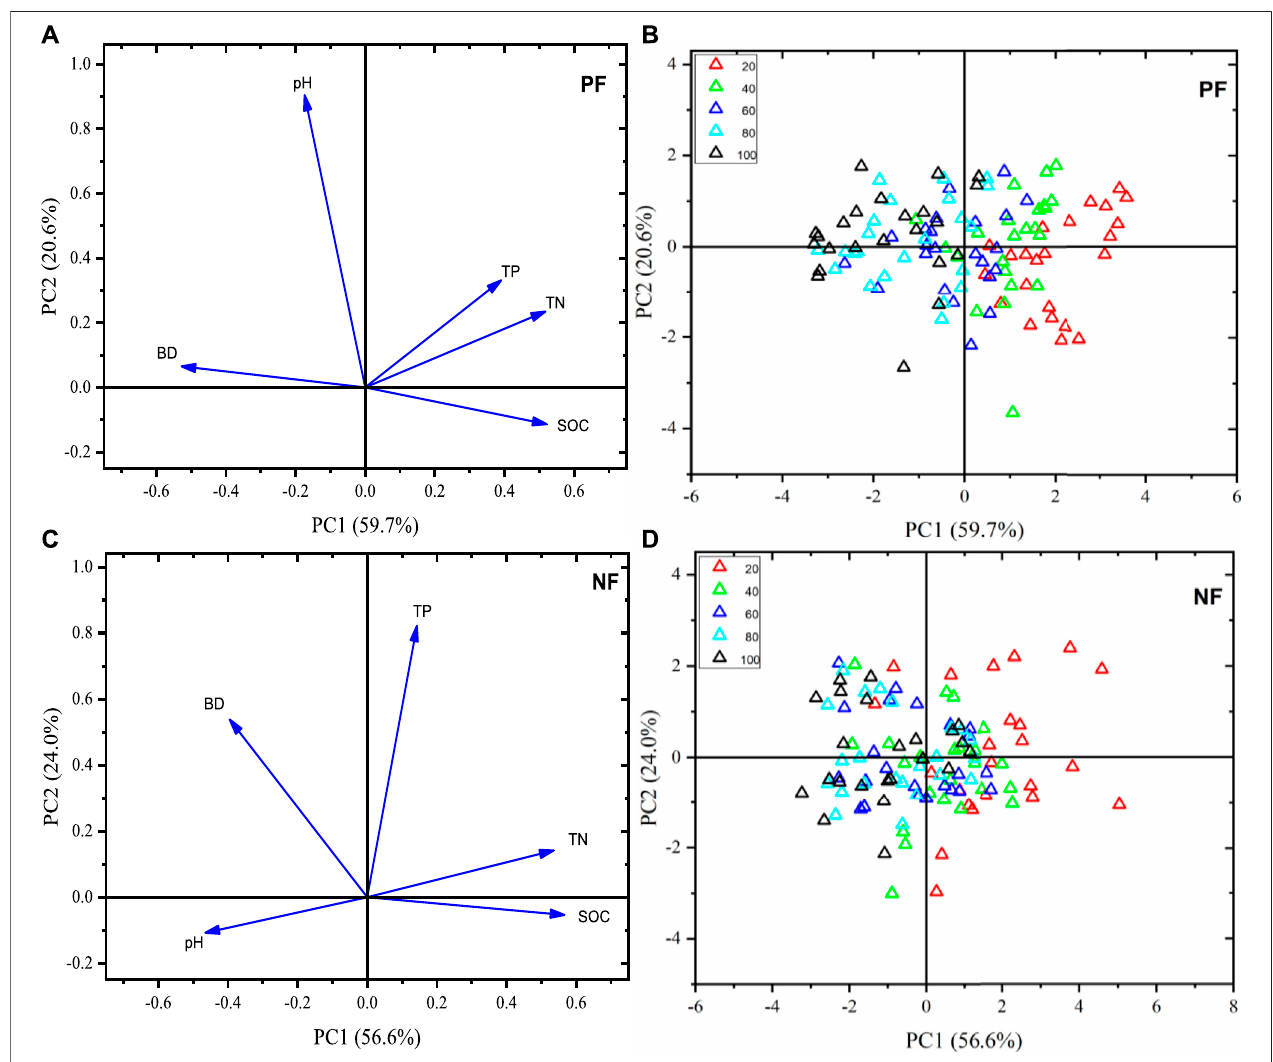
FIGURE 5 | Principal component analysis for the physicochemical soil properties (loading and score plot). Panels (A, C) show the association of physicochemical soil parameters. At the same time, panels (B, D) represent the position of different soil depths (0 – 100 cm) under PF and NF.